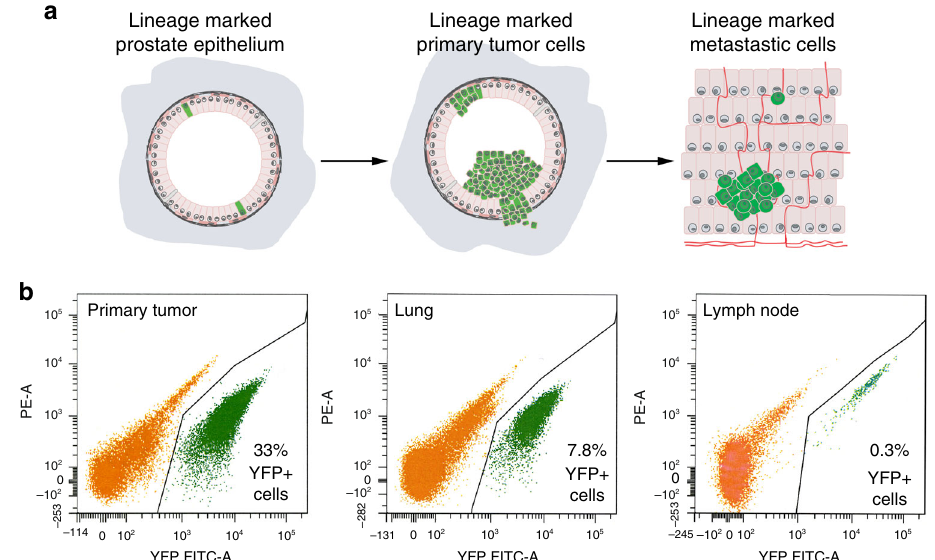
Fig. 1 Strategy for molecular pro fi ling of tumors and metastases. a Lineage tracing of YFP-labeled (green) prostate epithelial cells at the time of tumor induction leads to YFP-labeled cells in tumors and metastases. b Lineage-marked cells from primary tumors, or lung or lymph node metastases were isolated by fl uorescence activated cell sorting (FACS). Shown are representative images with percentages of YFP-labeled cells indicated; axes show fl uorescent intensity of the fl uorescein isothiocynate (FITC-A) and phycoeritrin (PE)